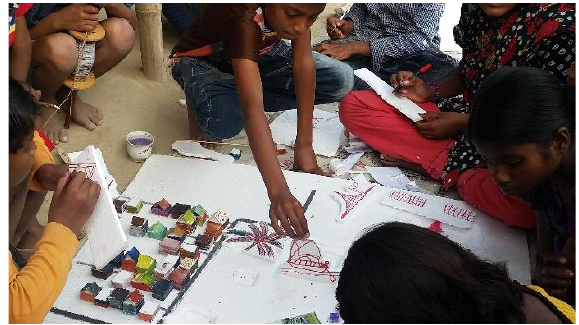
Figure 7: Children designing their desired playground Along with the NGO Alive, the communities assigned 2/3 members as the procurement and